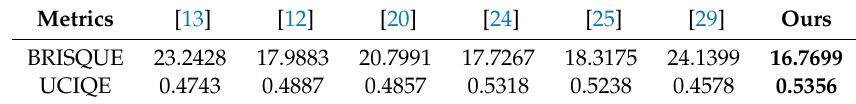
Table 3. Quantitative results on real-world underwater images in terms of BRISQUE and UCIQE.